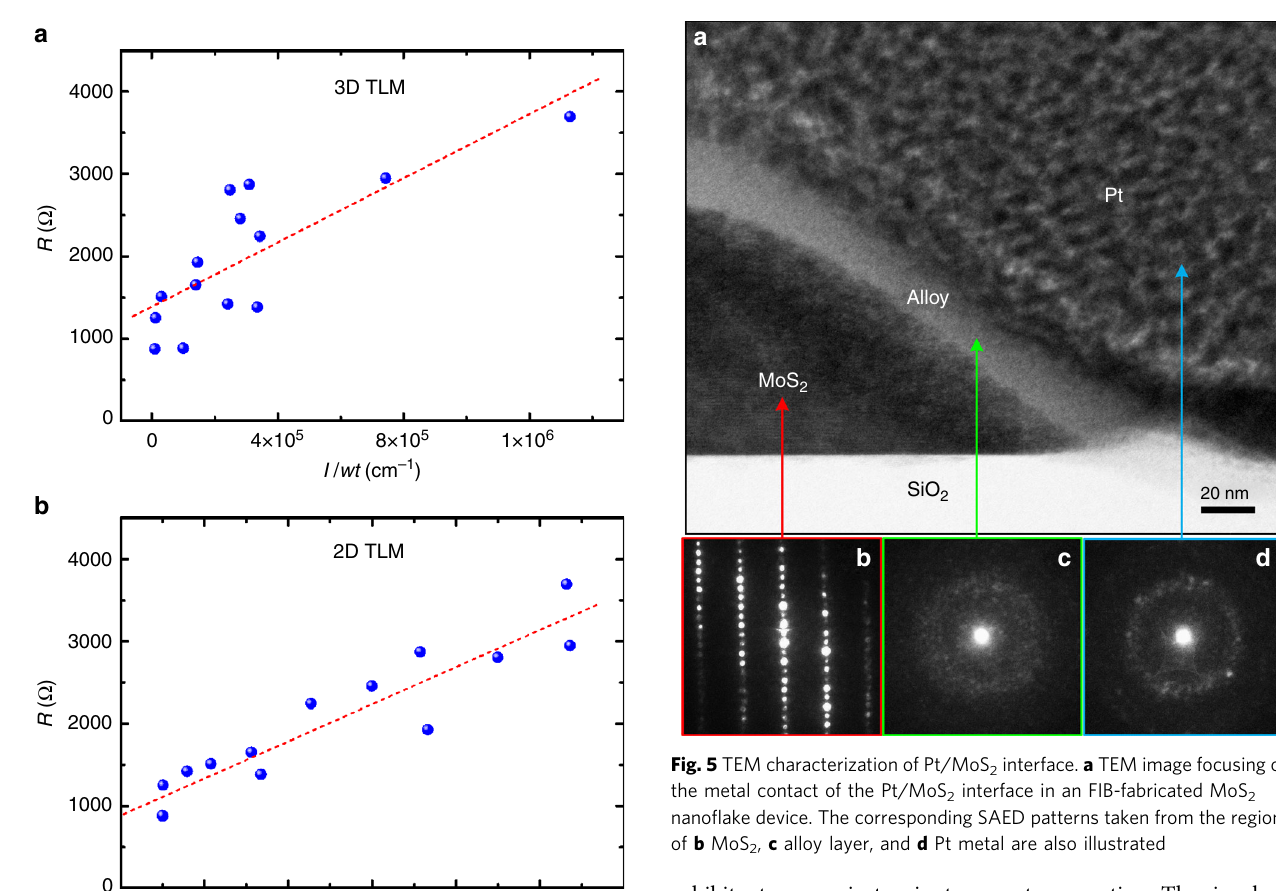
MoS 2 is relatively simple because pretreatment of the contact not necessary. The metal deposition area is selective, and ohmic contact is formed simultaneously with metal deposition through FIB processing. The formation of a conducting amorphous alloy layer in the Pt and MoS 2 interface could be the reason for the low contact resistance obtained using the FIB approach, as is discussed in the following section.